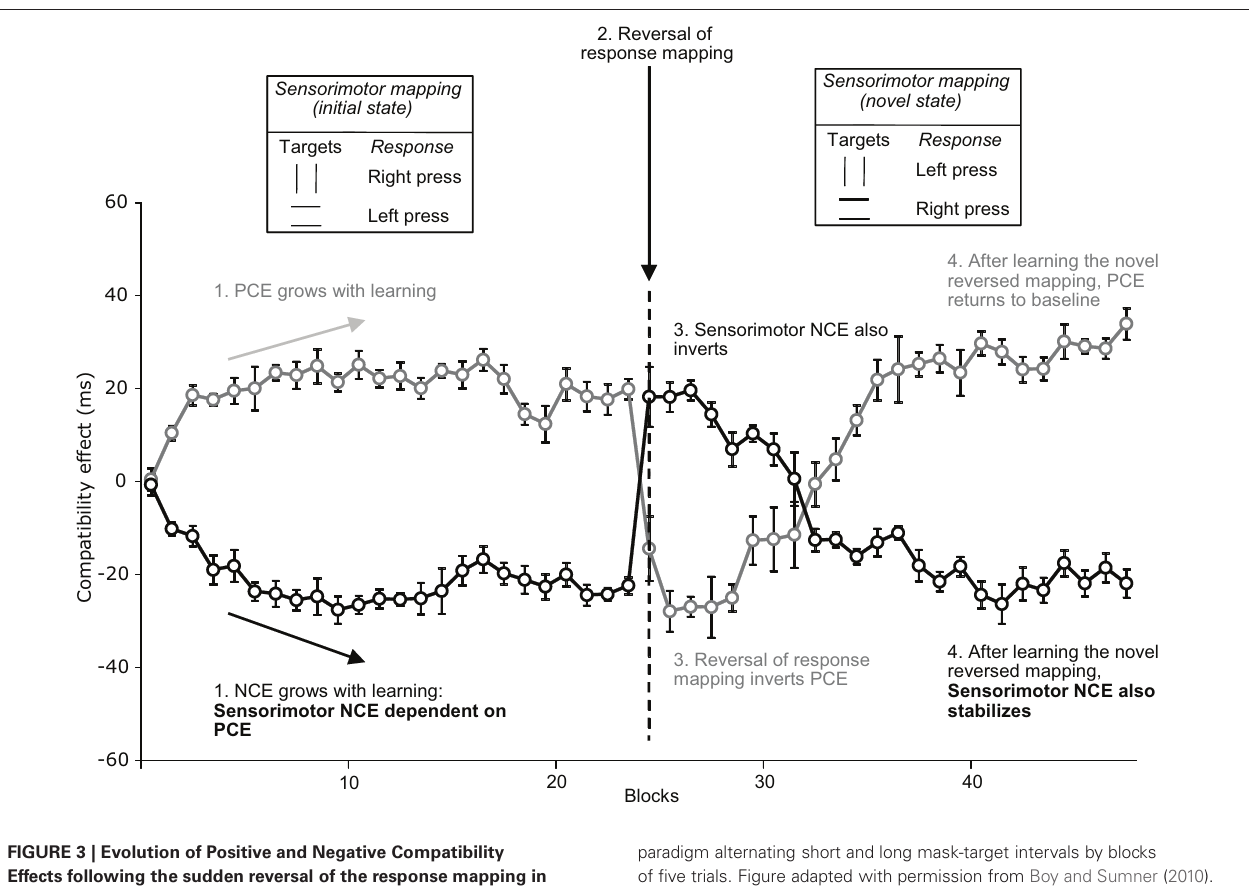
FIGURE 3 | Evolution of Positive and Negative Compatibility Effects following the sudden reversal of the response mapping in the paradigm used by Boy and Sumner (2010, Experiment 4). Participants were trained to respond to targets in a masked prime